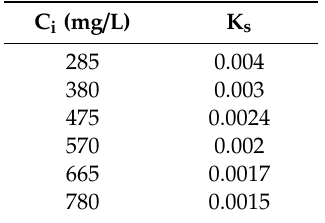
Table 4. The Langmuir-based K s value.